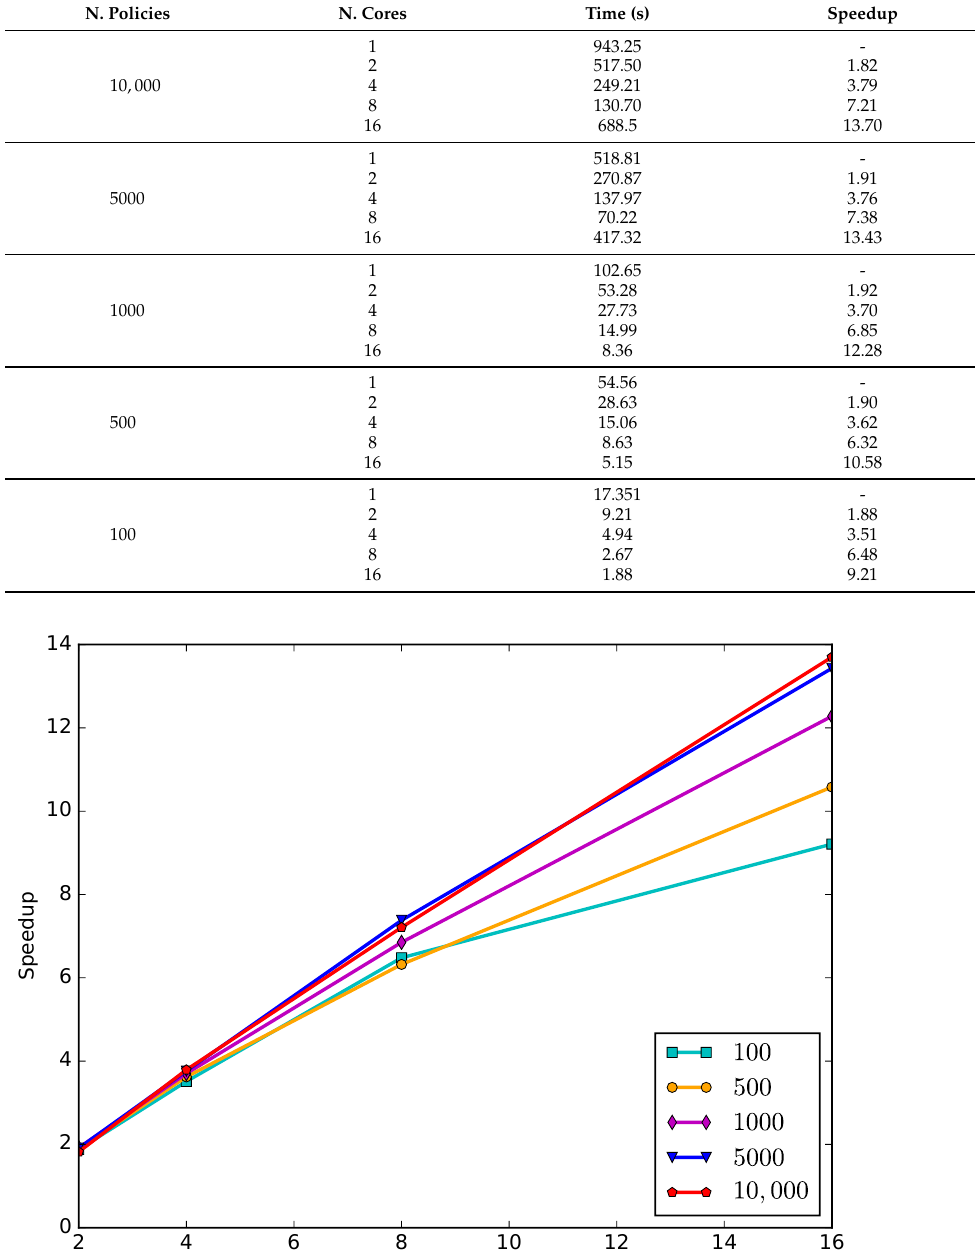
Table 3. Parallel implementation of the risk functional evaluation. Time and speedups.